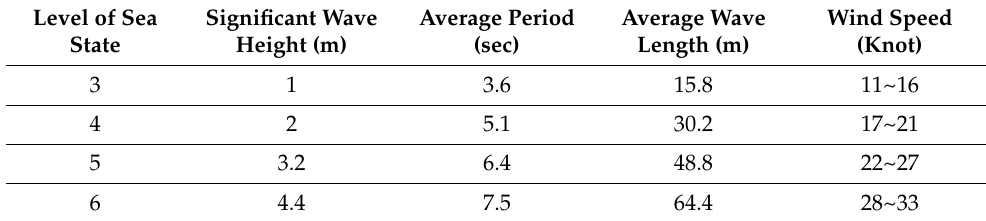
Table 1. Sea state table.